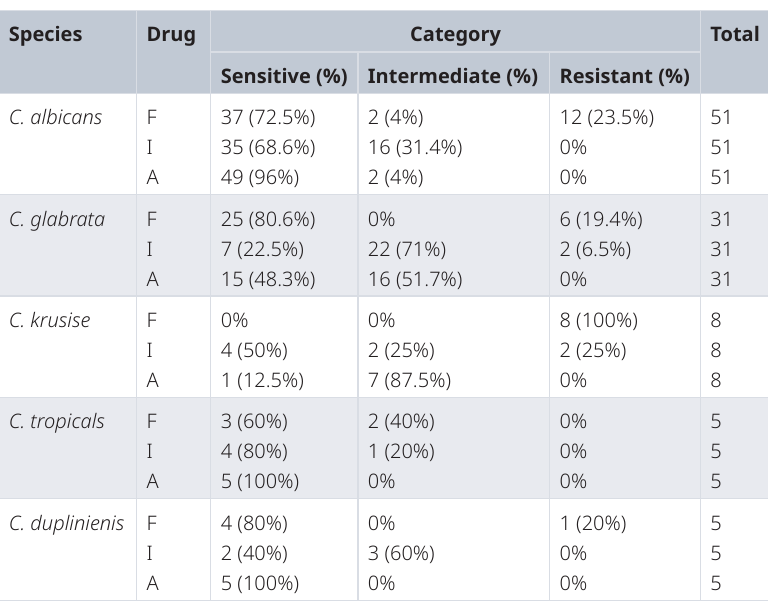
Table 2. The sensitivities of different species towards the selected antifungal